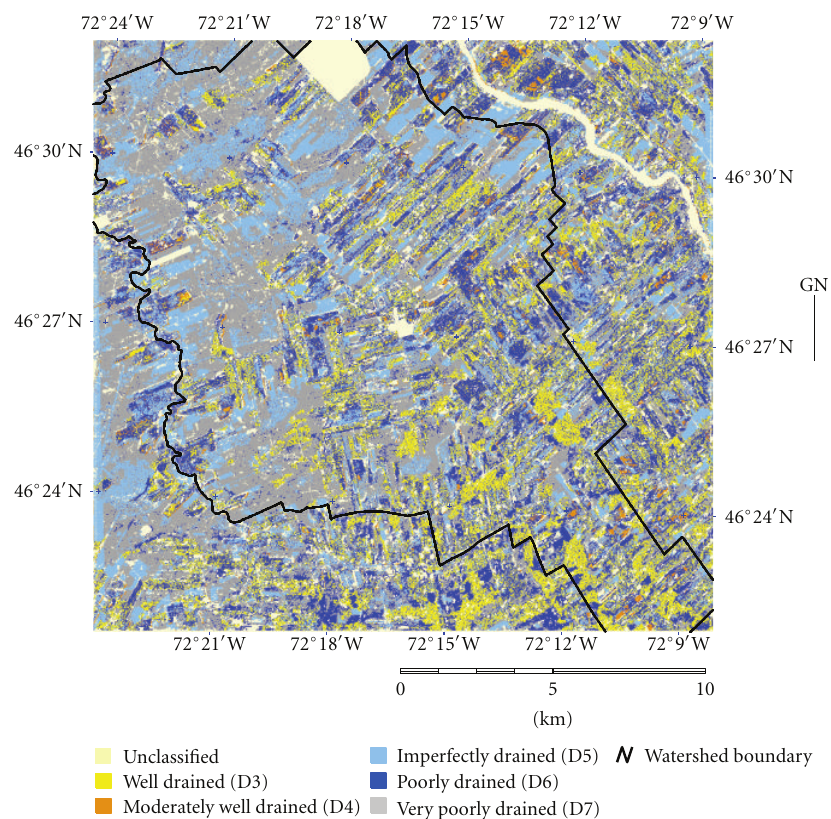
Figure 8: Soil drainage map derived from the decision tree classifiers (DTC).